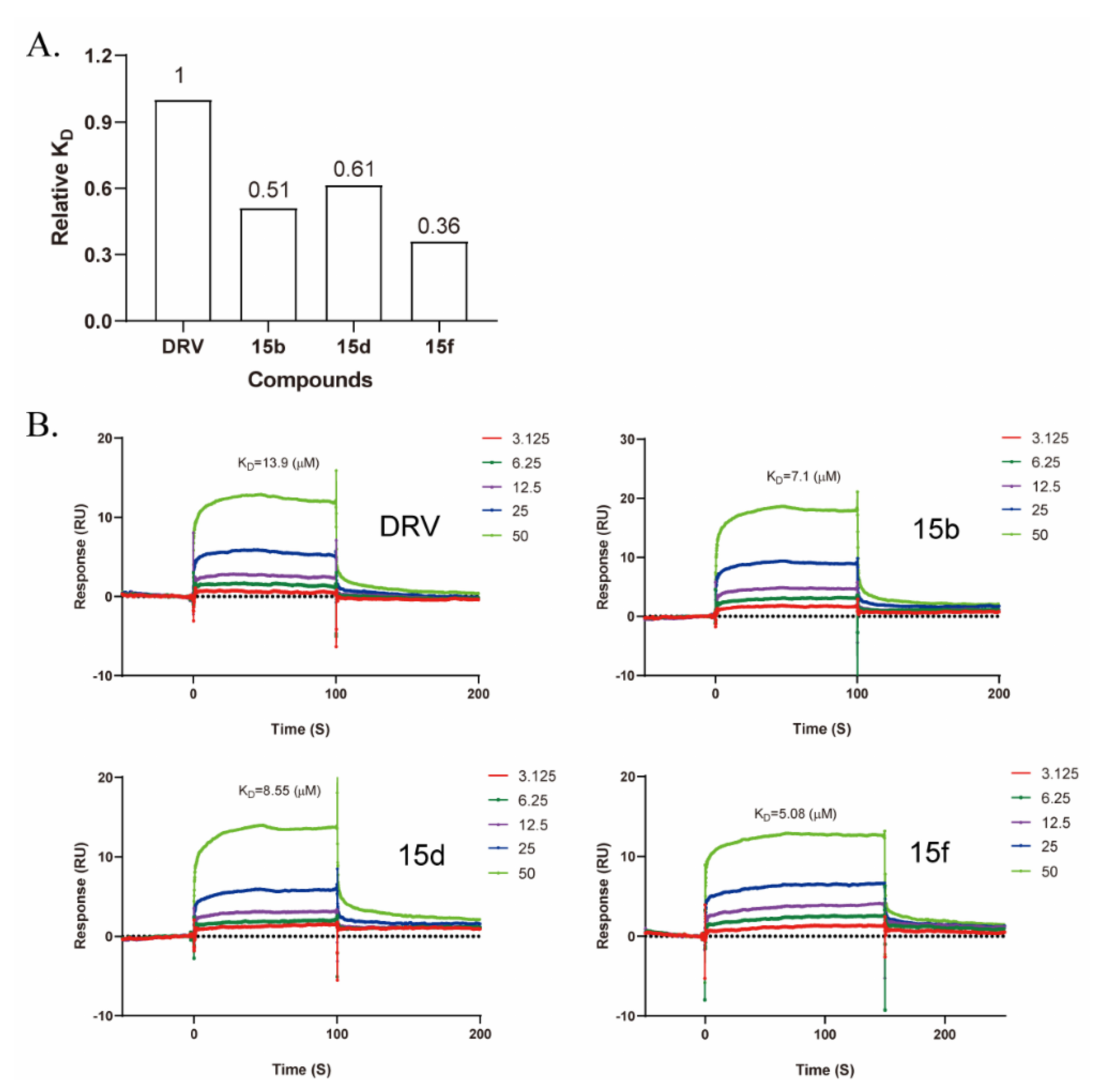
Figure 7. Kinetic and equilibrium binding analysis of selected inhibitors binding to the protease. Purified HIV-1 protease was immobilized on a CM5 sensor chip using a Biacore T200 instrument. The association and dissociation curves of these compounds are shown. Compounds were dissolved with a series of increasing concentrations, and KD values were acquired from fitting to a 1:1 binding model using Biacore T200 evaluation software 2.0. KD, equilibrium dissociation constant. All assays were conducted in triplicate, and the data shown represent one of three independent